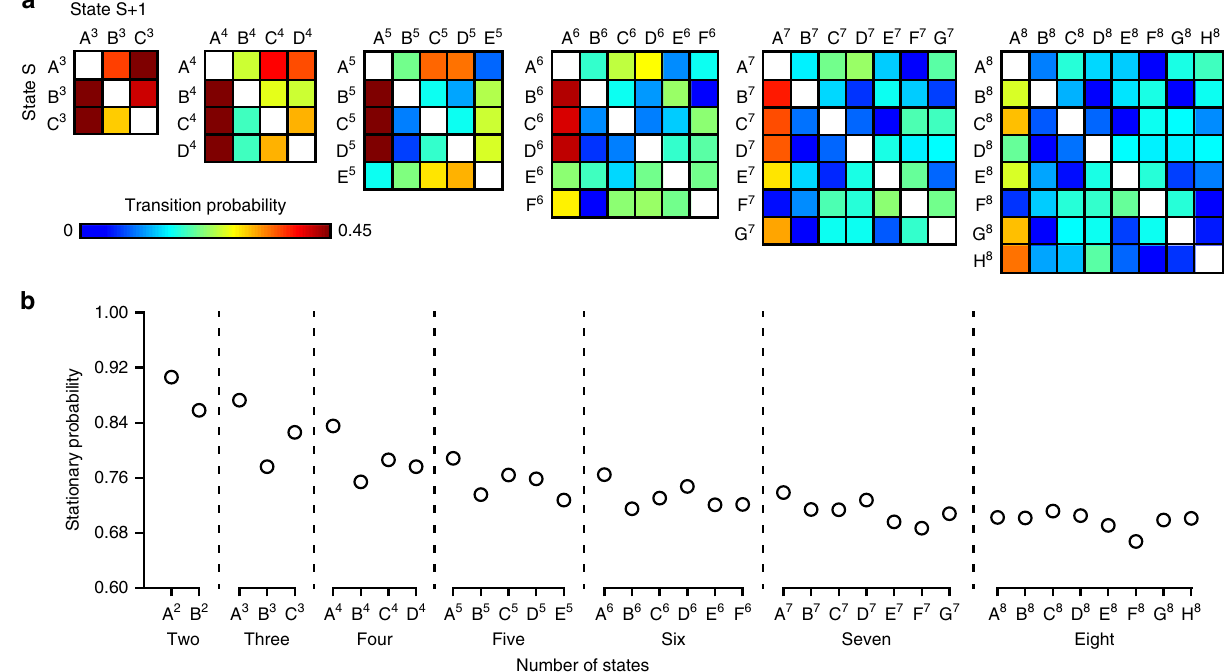
Fig. 3 Evidence for an attractor state. a When transitioning between states, participants display an increased probability of entering state A. The probability of transitioning to each state is shown for all nonredundant possible combinations across state solutions 3 – 8 (1, 2 are obligated). Each row sums to 1. b State A displays the increased probability of remaining in the same state for solutions 2 – 5 ( p s ≤ 0.001). The graph re fl ects the tendency for states in solutions 2 – 8 to show steady-state behavior, or the probability of remaining in a given state from time point t to time point t +